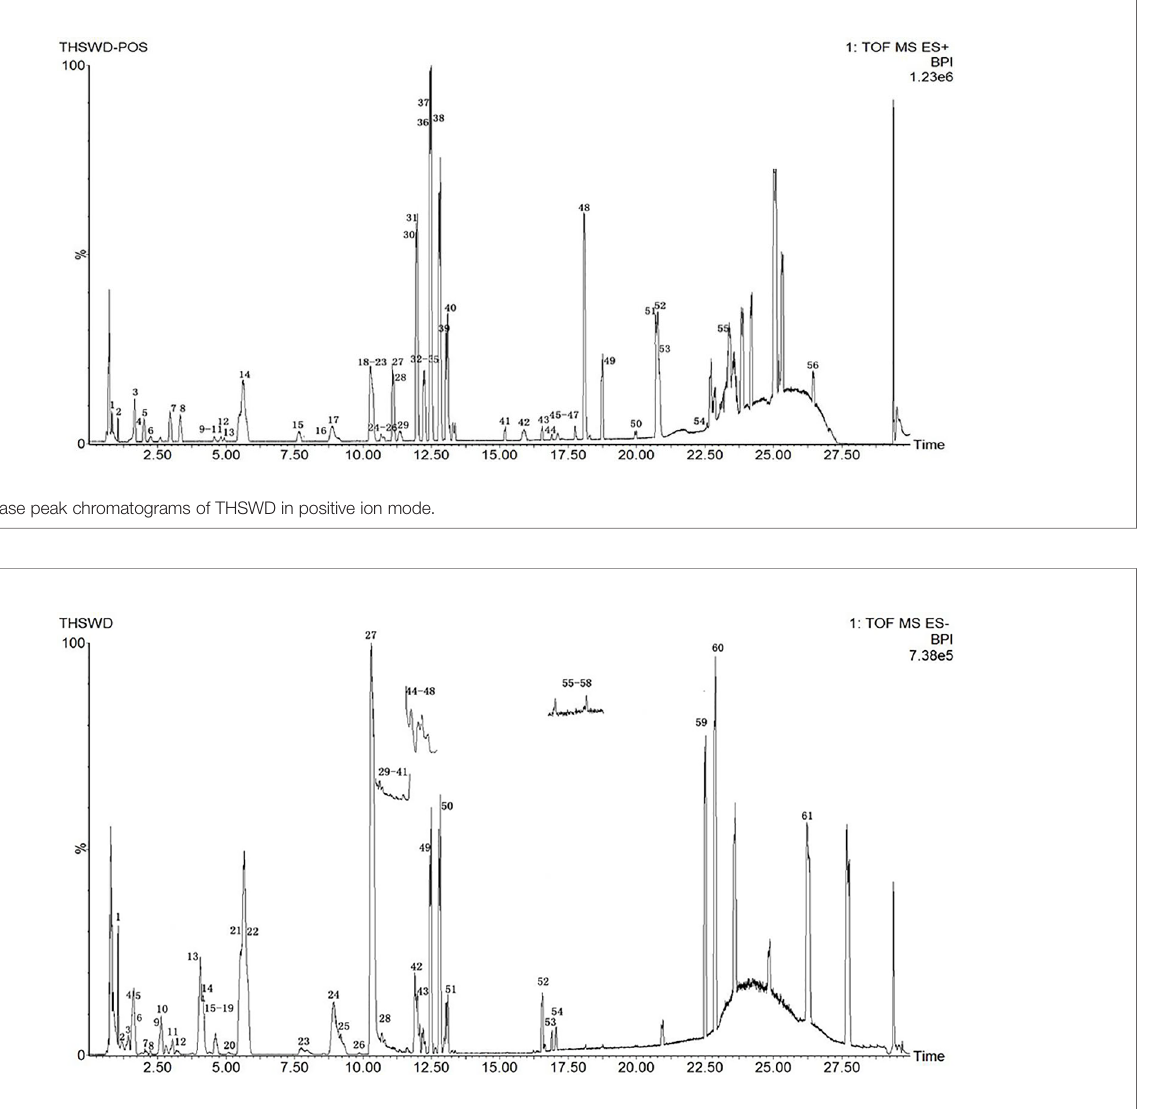
FIGURE 2 | Base peak chromatograms of THSWD in negative ion